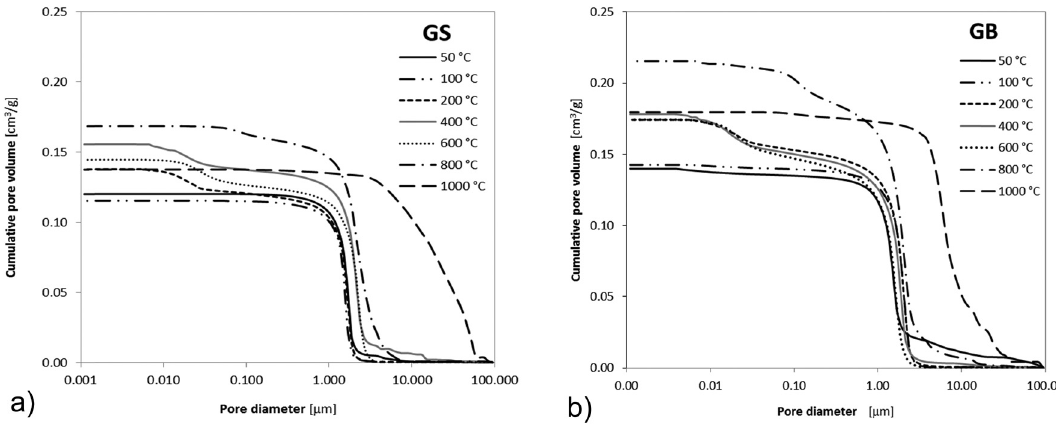
Figure 13: Pore size distribution curves after exposition to high temperatures: ( a ) GS and ( b ) GB.